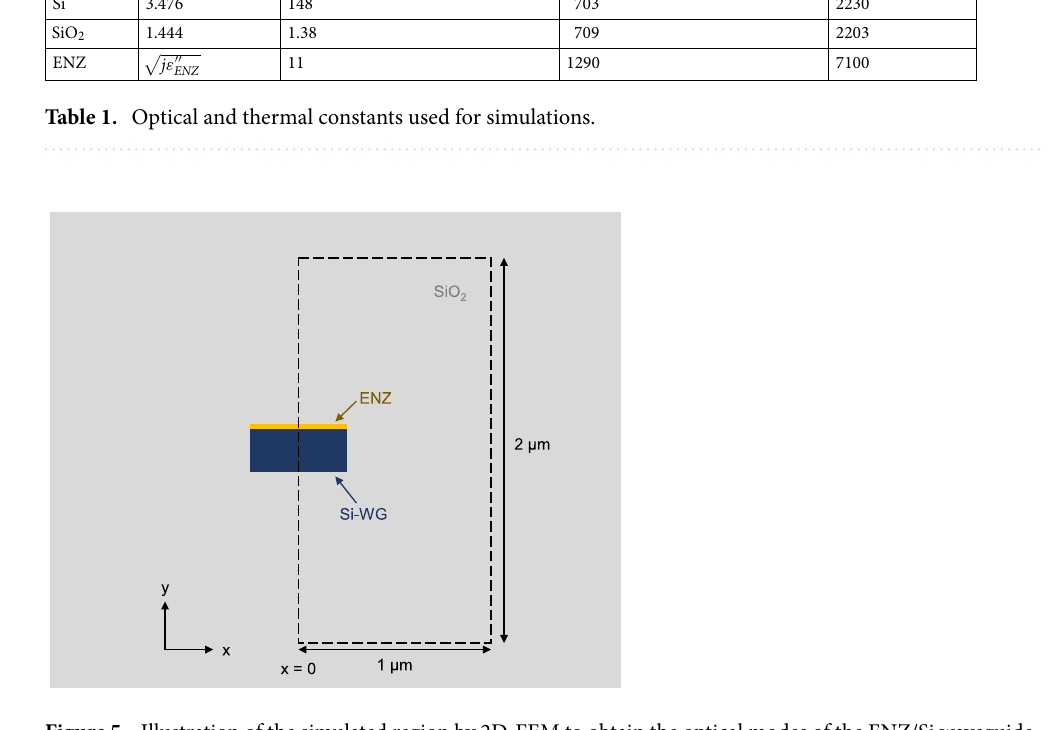
Figure 5. Illustration of the simulated region by 2D-FEM to obtain the optical modes of the ENZ/Si waveguide. The ENZ layer was removed in the case of the Si-only